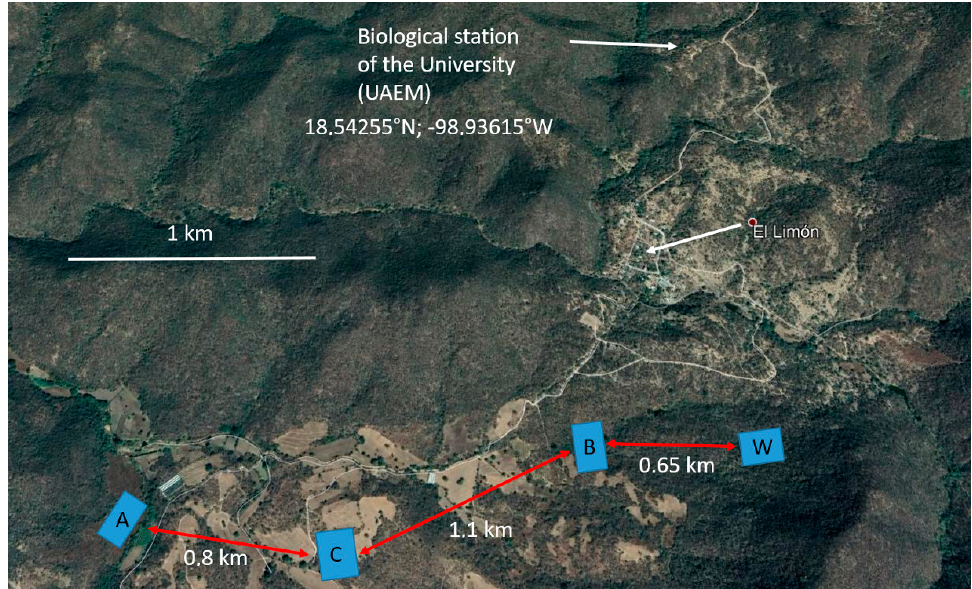
Figure 1. Localities of sampling (northeast of the Biosphere reserve of the Sierra de Huautla, Morelos State, Mexico (see Figure A2)). Reference: biological station of “El Limon” 18°32’33.12” N; 98°56’10.22” W (Source: INEGI/CNES 2020). Zone A has not been exploited for 5–6 years; Zone B for 11–15 years; Zone C for 25–26 years; and Zone Wild (W) the reference, representing primary dry tropical forest. Each sampling zone (in blue) is a 2 ha plot, approximately 180 × 110 m.